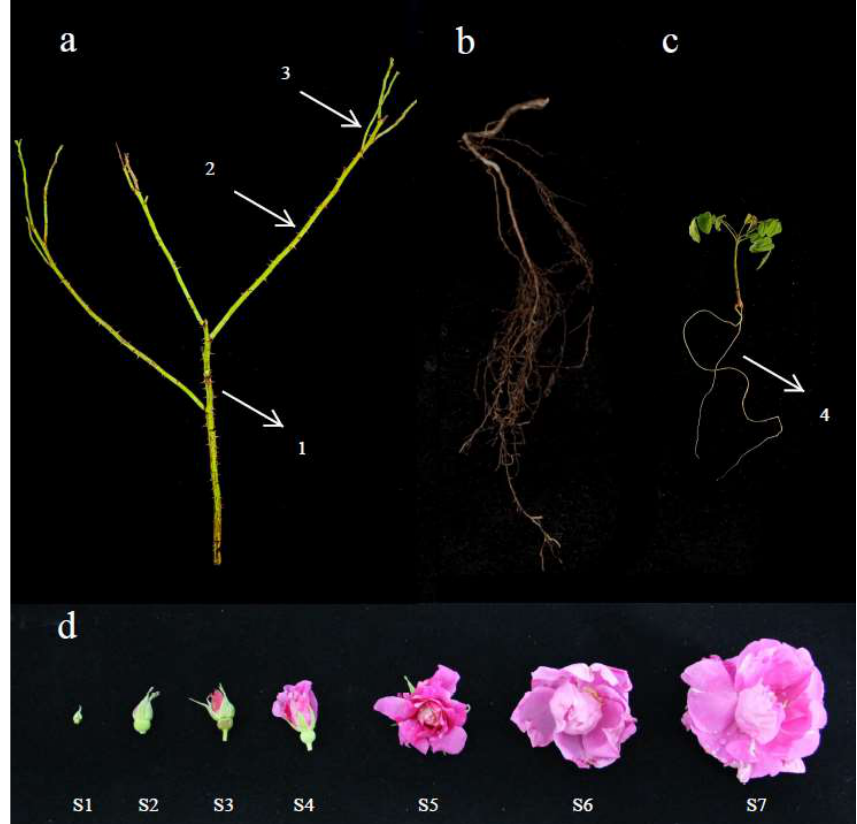
Figure 6. The lateral branches ( a ), primary lateral branch (1), secondary lateral branch (2), tertiary lateral branch (3). Roots ( b ) and roots of tissue culture seedlings ( c ) (4). Petals at different development stages ( d ), S1: Large bud stage, S2: Reddish stage, S3: Flowering initiation stage, S4: Flower bud half-opening stage, S5: Initial opening stage, S6: Semi-opening stage, S7: Full opening stage.